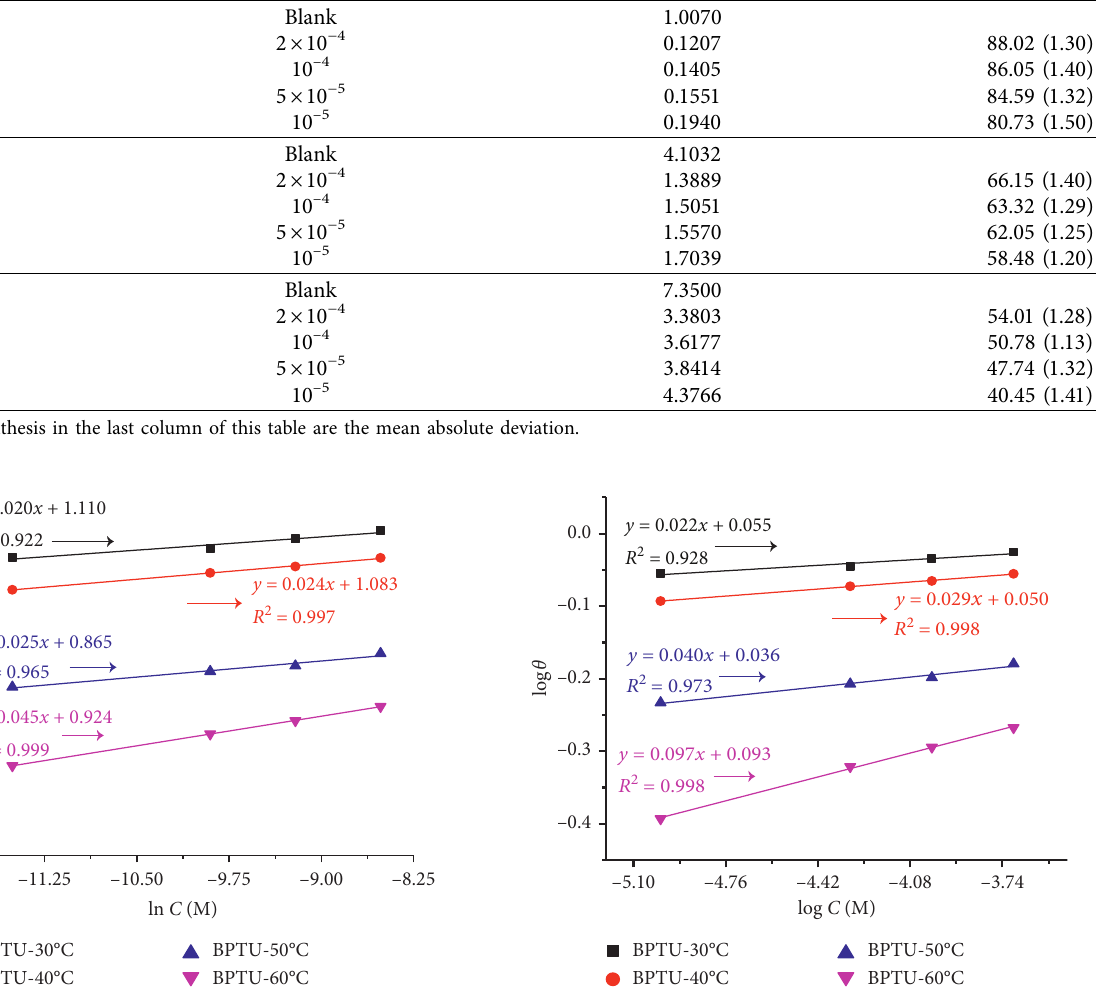
Table 3: Polarization curve parameters of low carbon steel in 1.0M HCl with different concentrations of BPTU at 40, 50, and 60 ° C ∗∗∗ . Temperatures ( ° C)